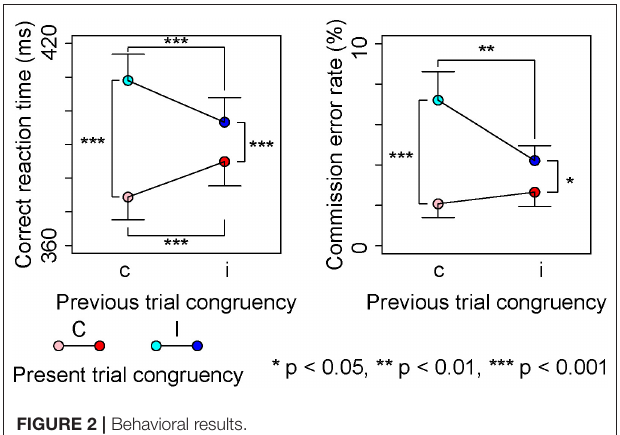
FIGURE 2 | Behavioral